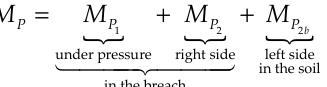
Figure 4. ( a ) The bending moment generated by dead weight M G . ( b ) Moments of force due to water pressure depending on the soil permeability.